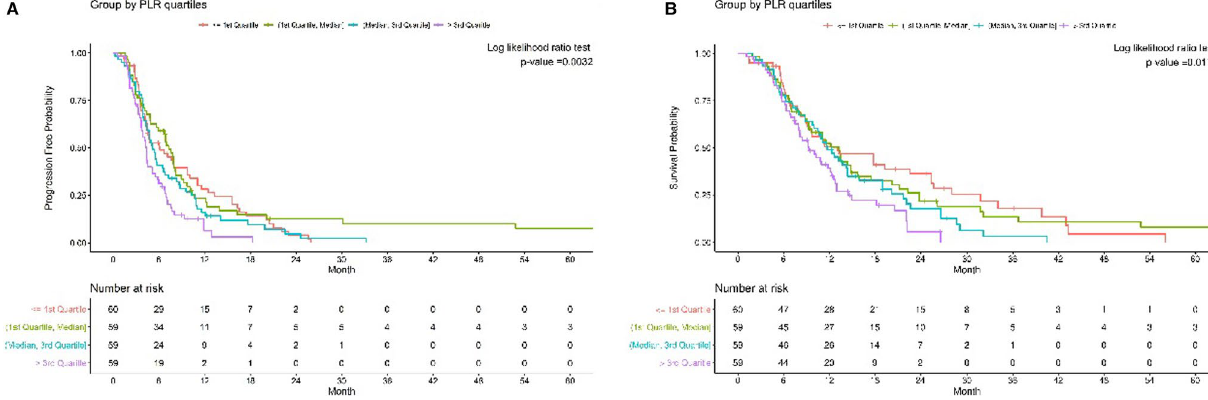
Fig. 2 Progression-free survival (PFS) ( A ) and Overall survival (OS) ( B ) in PLR based on